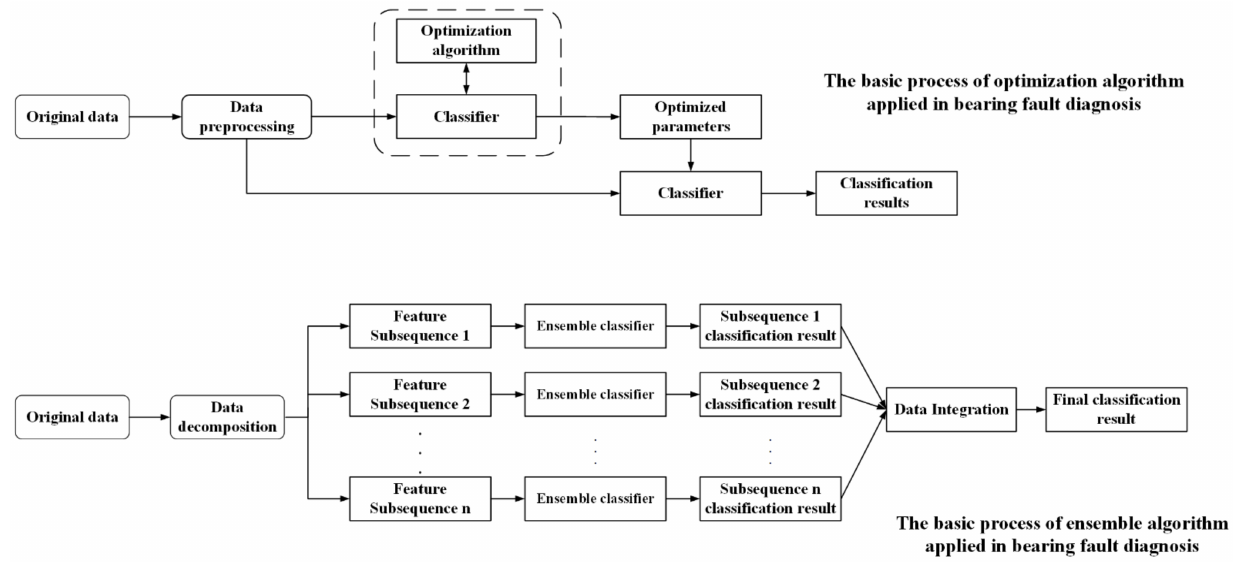
Figure 7. Basic structures of optimization algorithms and ensemble algorithms.